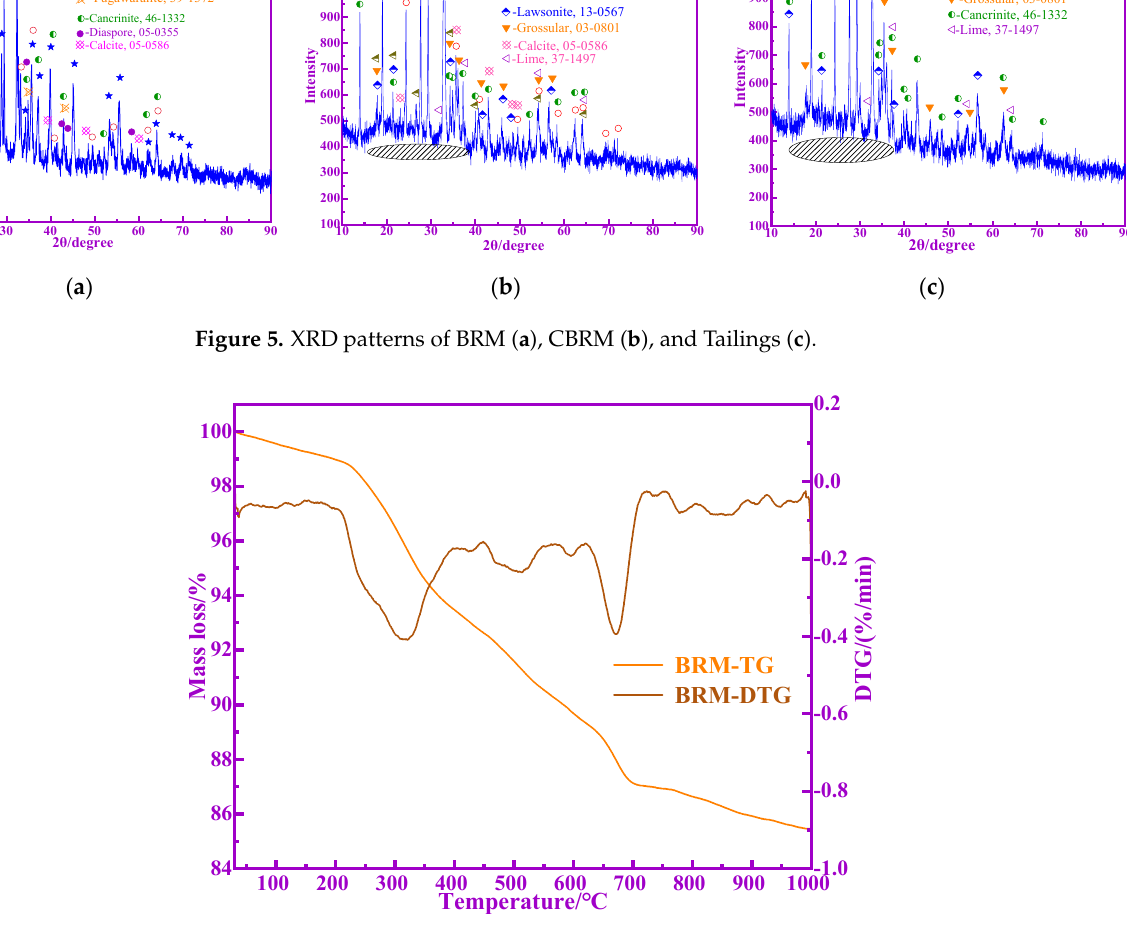
Figure 6. TG-DTG curves of BRM.